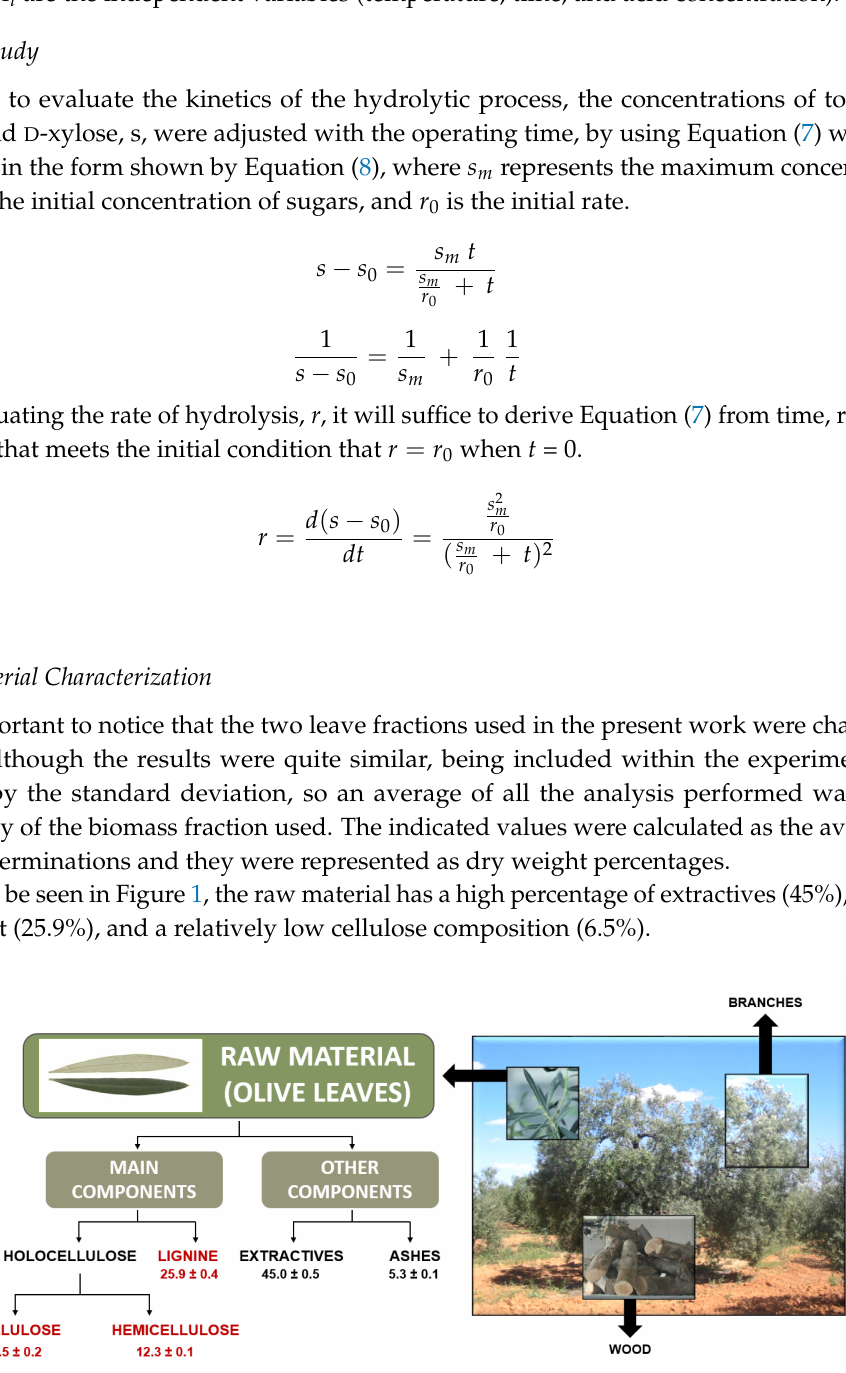
Figure 1. Composition of olive tree